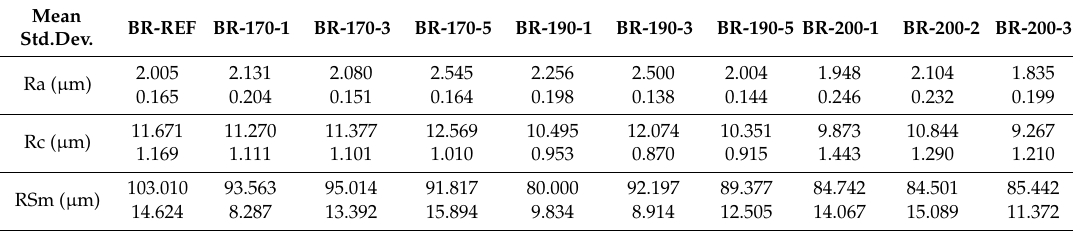
Table 2. The basic statistical analyses of the roughness parameters determined by the contact method. Mean